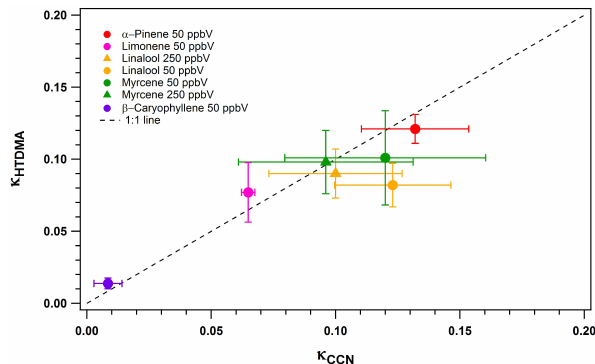
Fig. 8. Reconciliation of mean kappa values from HTDMA and CCN measurements. The vertical and horizontal variability bars represent one standard deviation for each measurement.